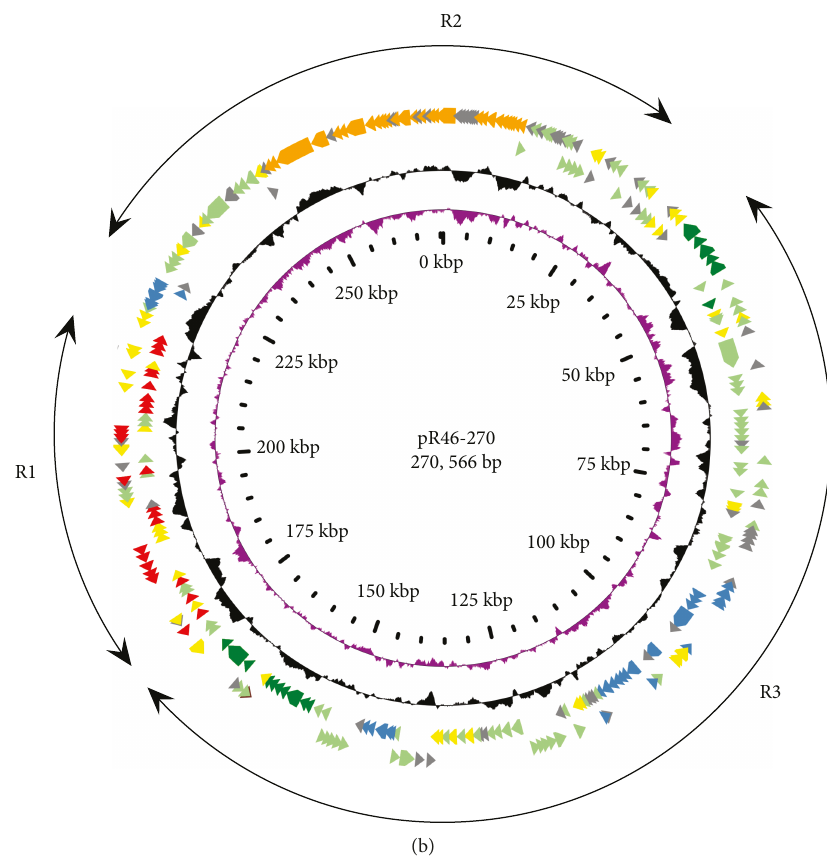
Figure 1: Circular maps of the plasmids pR46-27 (a) and pR46-270 (b). (a, b) Counting from the center toward the outside: (1) the inner most circle shows the position in kb. (2) GC skew (G-C/G+C), with a positive GC skew toward the outside and a negative GC skew toward the inside. (3) GC content, with an average of 50%, whereby a G+C content of more than 50% is shown toward the outside, otherwise, inward. (4) Genes encoded in the leading strands (outwards) or lagging strands (inwards). Genes with di ff erent functions are shown in di ff erent colors: red: drug resistance; yellow: mobile genetic elements; orange: transfer conjugation; green: virulence; blue: heavy metal resistance; gray: genes with unknown functions; light green: genes with other functions. (a) The plasmid pR46-27 was used as the reference genome and compared to the sequences of pCTXM-2771 (MF589339), pACN001-A (KC853434), and p160070-CTXM (MG288677). (b) R1: multidrug resistance region; R2: transfer and maintenance region; R3: heavy metal resistance and virulence